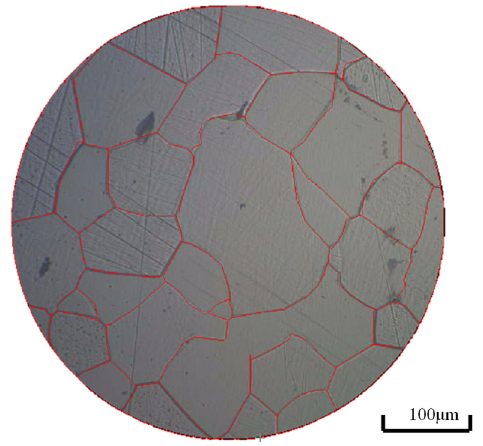
Figure 2. Statistical results of grain size of silicon steel plate.